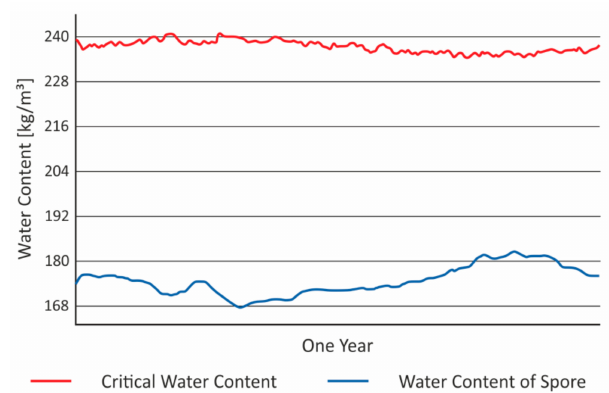
Figure 18. Changes in water content for the envelope according to the calculations for the indoor climate, ISO 13788.